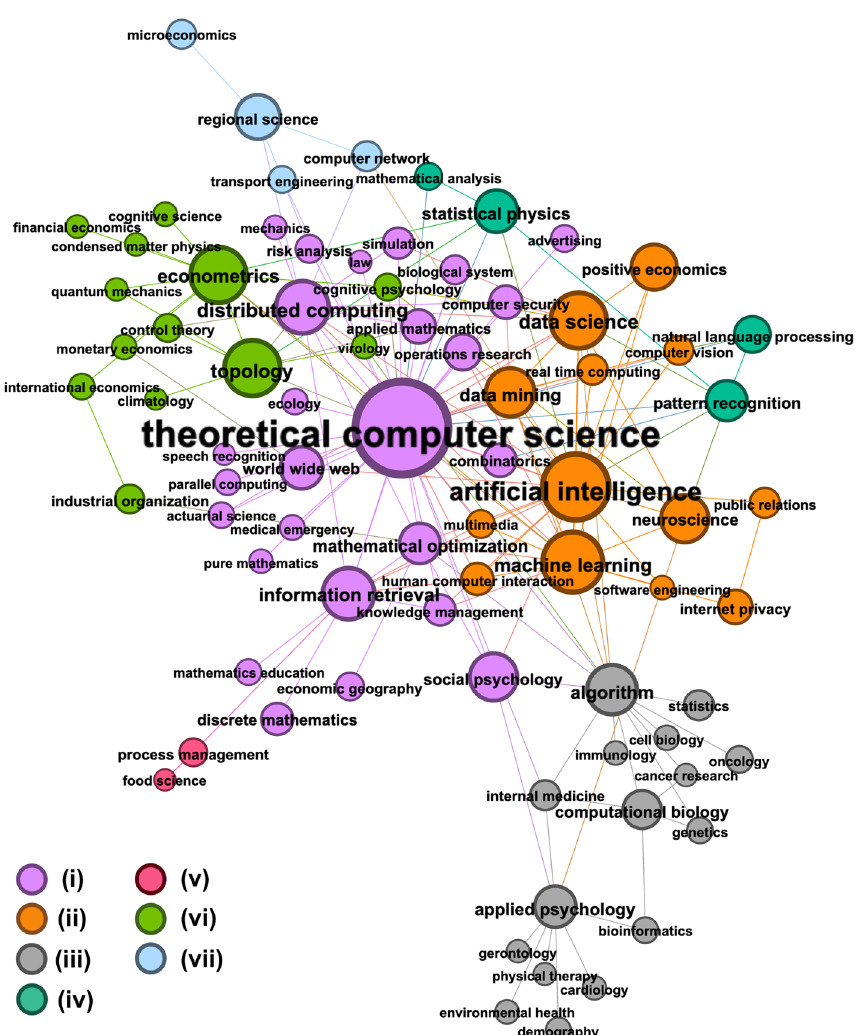
Fig. 4 FoS Network for research published in related to the journal “Applied Network Science” during 2016–2019. Nodes are coloured to show clusters identified by